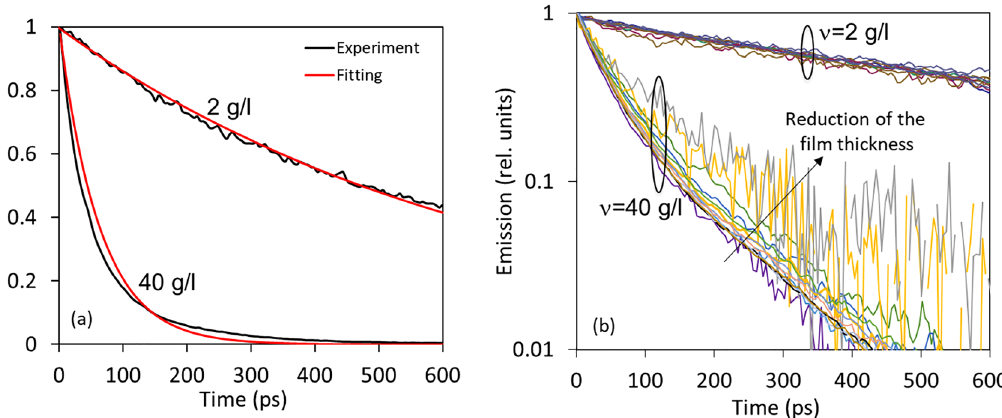
Figure 5: Dependence of the emission decay rates in HITC:PMMA films as the function of the film thickness d; ν = 40 g / l : Filled black circles (varied viscosity), open black circles (varied spinning rate), cross (drop casting), sold line – fi tting with formula C + B (1 − exp( − d / d 0 )); ν = 30 g / l : Green triangles, sold line – fi tting with formula C + B (1 − exp( − d / d 0 )); ν = 3 . 6 g / l :Openred,blue,and purple diamonds; ν = 2 g / l : Filled black squares. Vertical dashed line shows an onset of scattering. The error bars are